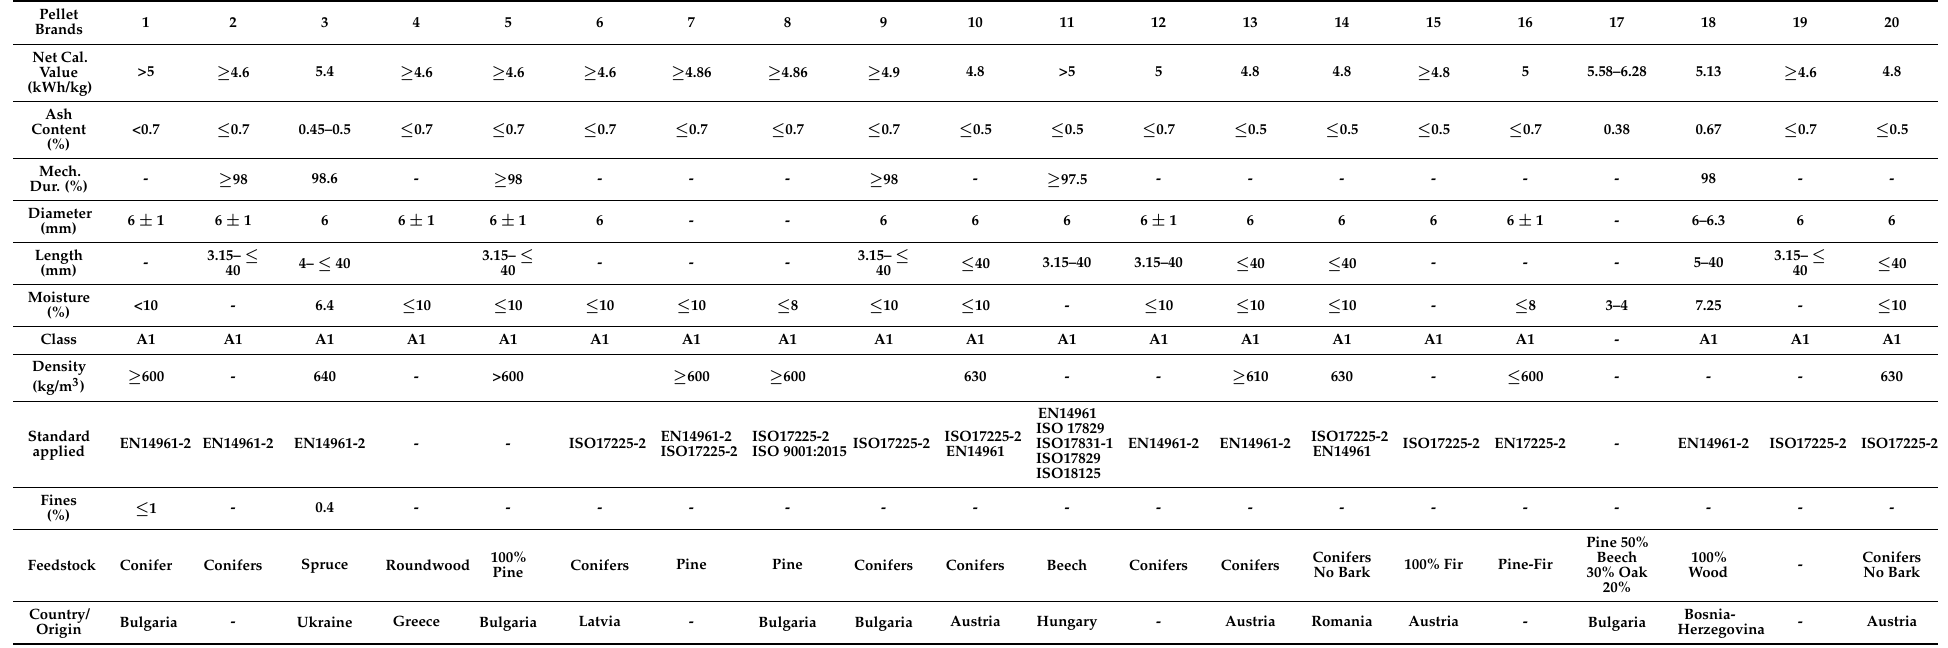
Table 1. Technical information and quality classes reported on the packaging of the 20 different pellet